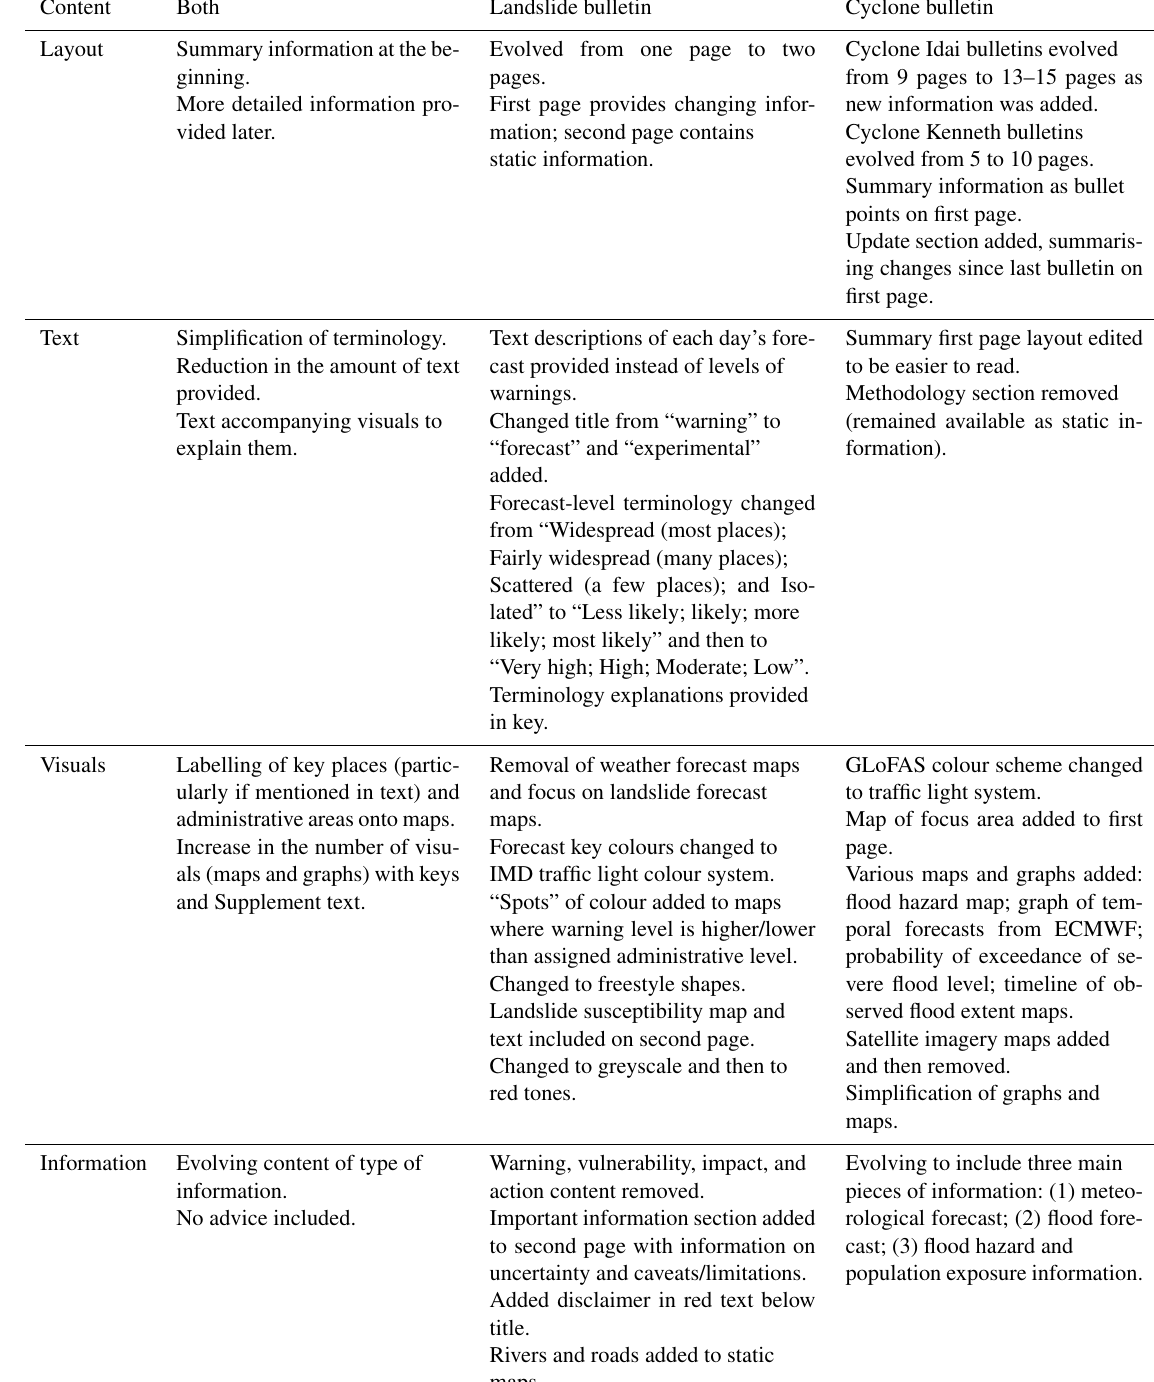
Table 3. Key features and changes to the content of the bulletins, including layout, text, visuals, and